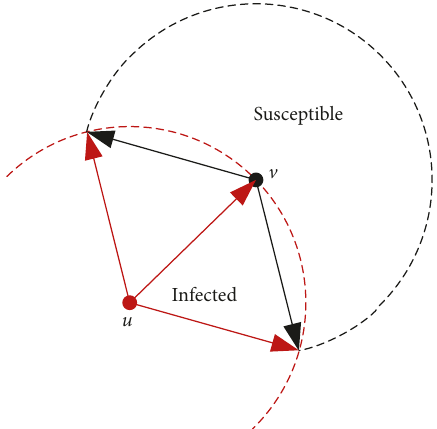
Figure 2: Infections outside the